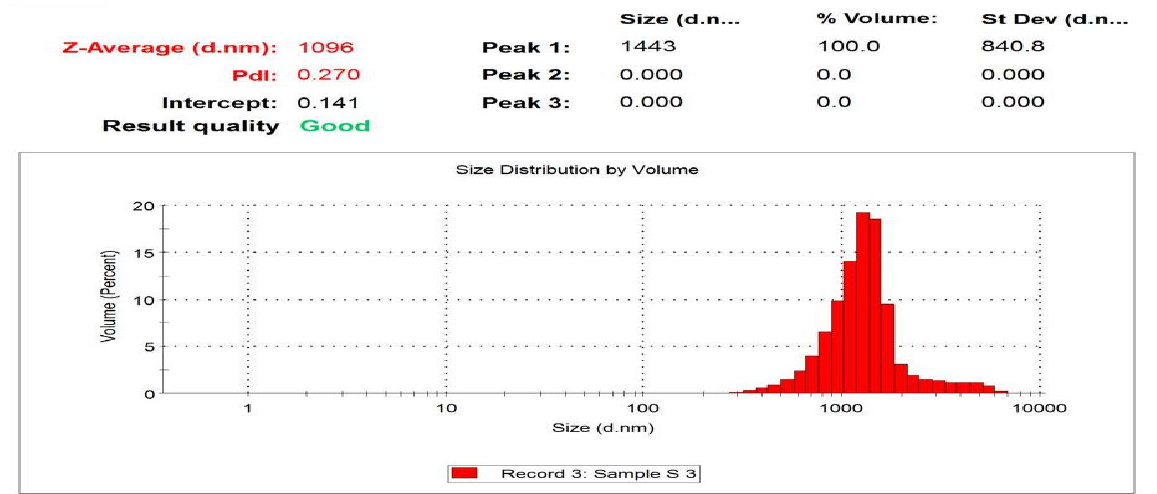
Figure 7: Particle size distribution by percentage volume